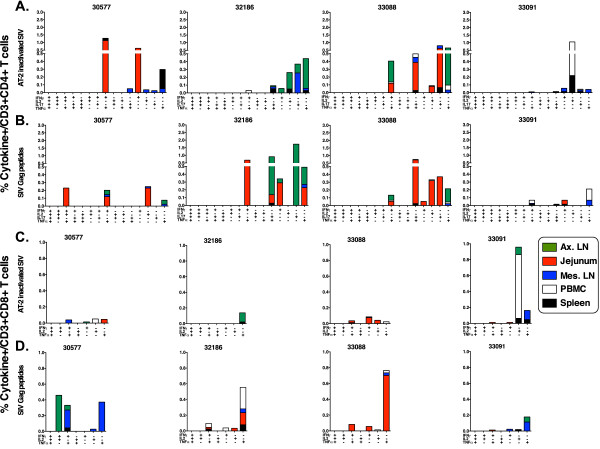
SIV-specific T cell responses. The response of CD3 + CD4+ (A, B) and CD3 + CD8+ (C, D) T cells after stimulation of PBMC or lymphoid cells with AT-2 (A,C) or SIVgag p27 overlapping peptides (B,D) and assessed for production of intracellular cytokines. Data are expressed as the frequency of cells positive for a set of cytokines, with tissue-specific responses represented by different colors: axillary lymph node (green), jejunum (red), mesenteric lymph node (blue), PBMC (white), spleen (black).